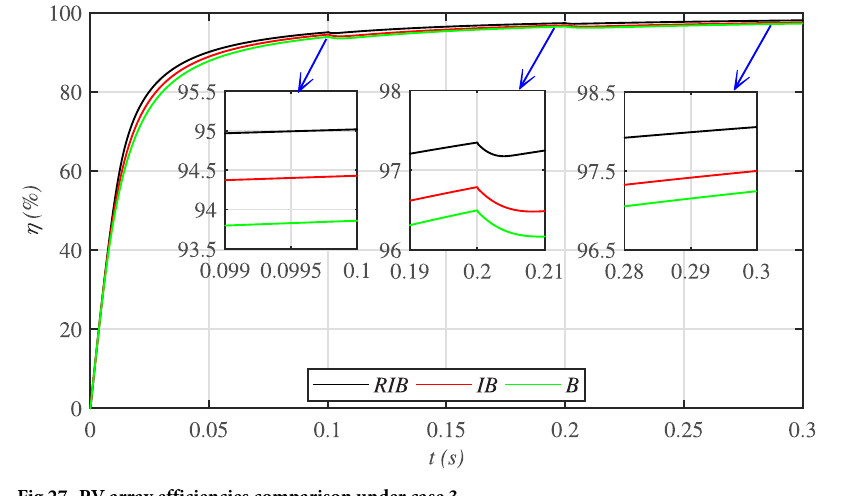
Fig 27. PV array efficiencies comparison under case 3.